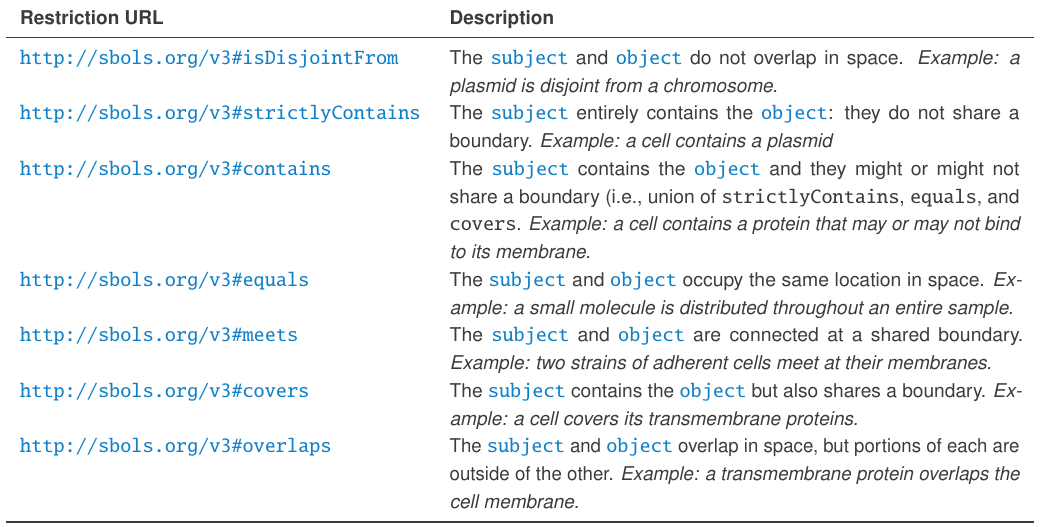
Table 9: RECOMMENDED URL s for expressing topological relations with the restriction property.